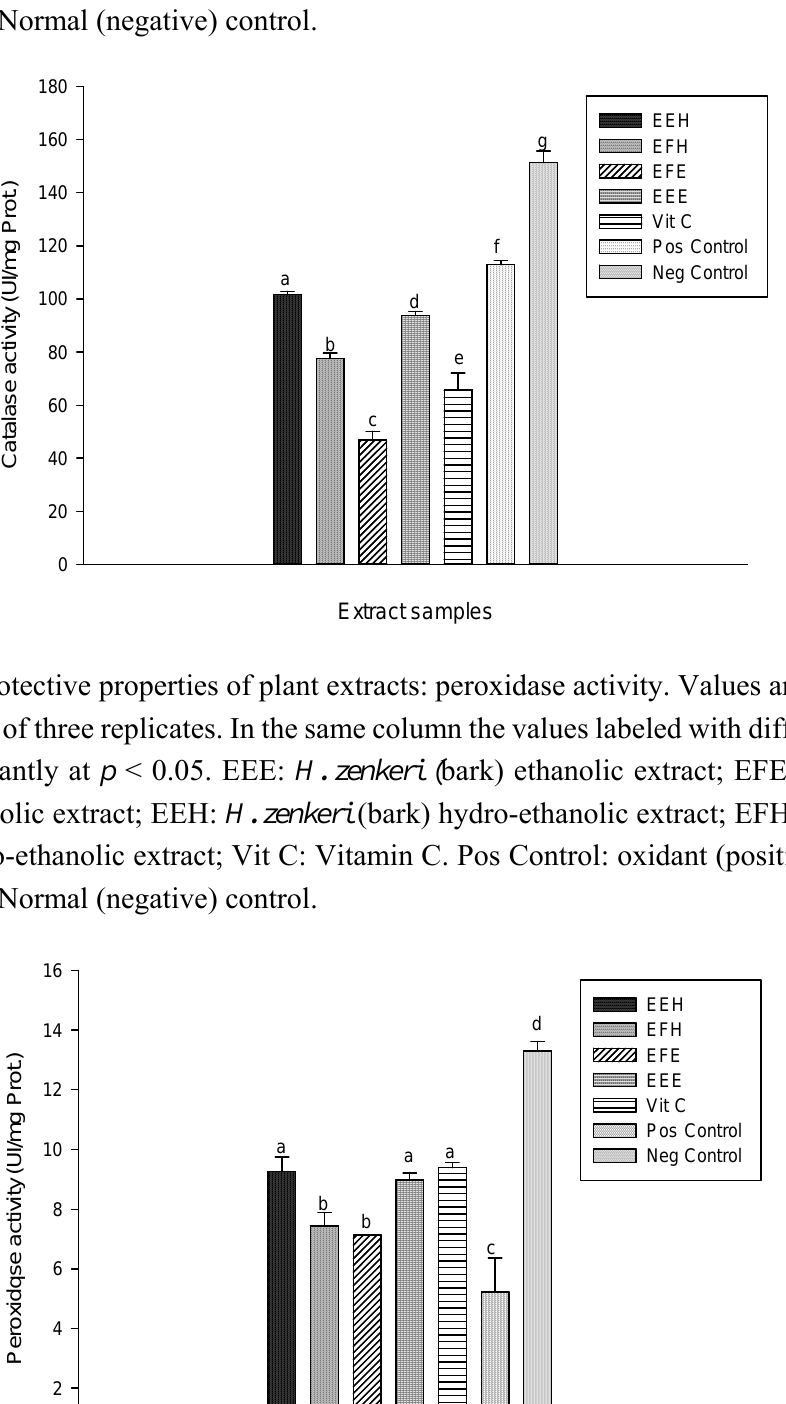
Figure 10. Protective properties of plant extracts: catalase activity. Values are expressed as mean ± SD of three replicates. In the same column the values labeled with different letters differ significantly at p < 0.05. EEE: H. zenkeri ( bark) ethanolic extract; EFE: H. zenkeri (leaves) ethanolic extract; EEH: H. zenkeri (bark) hydro-ethanolic extract; EFH: H. zenkeri (leaves) hydro-ethanolic extract; Vit C: Vitamin C. Pos Control: oxidant (positive) control. Neg Control: Normal (negative) control.